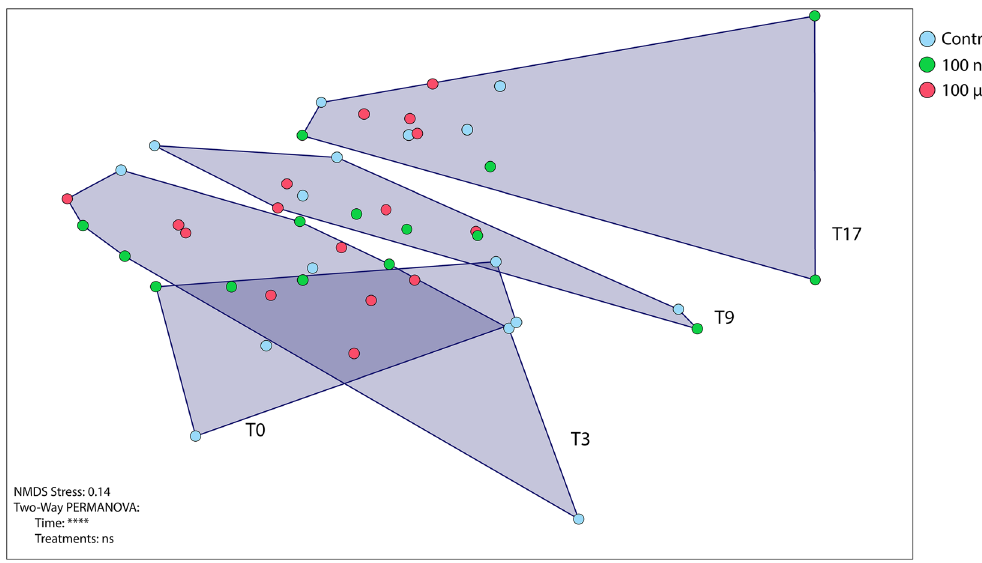
Figure 2. Non-metric multidimensional scaling (NMDS) ordination using Bray–Curtis dissimilarity, based on abundances of OTUs in samples from Mussismilia harttii treatments (n =